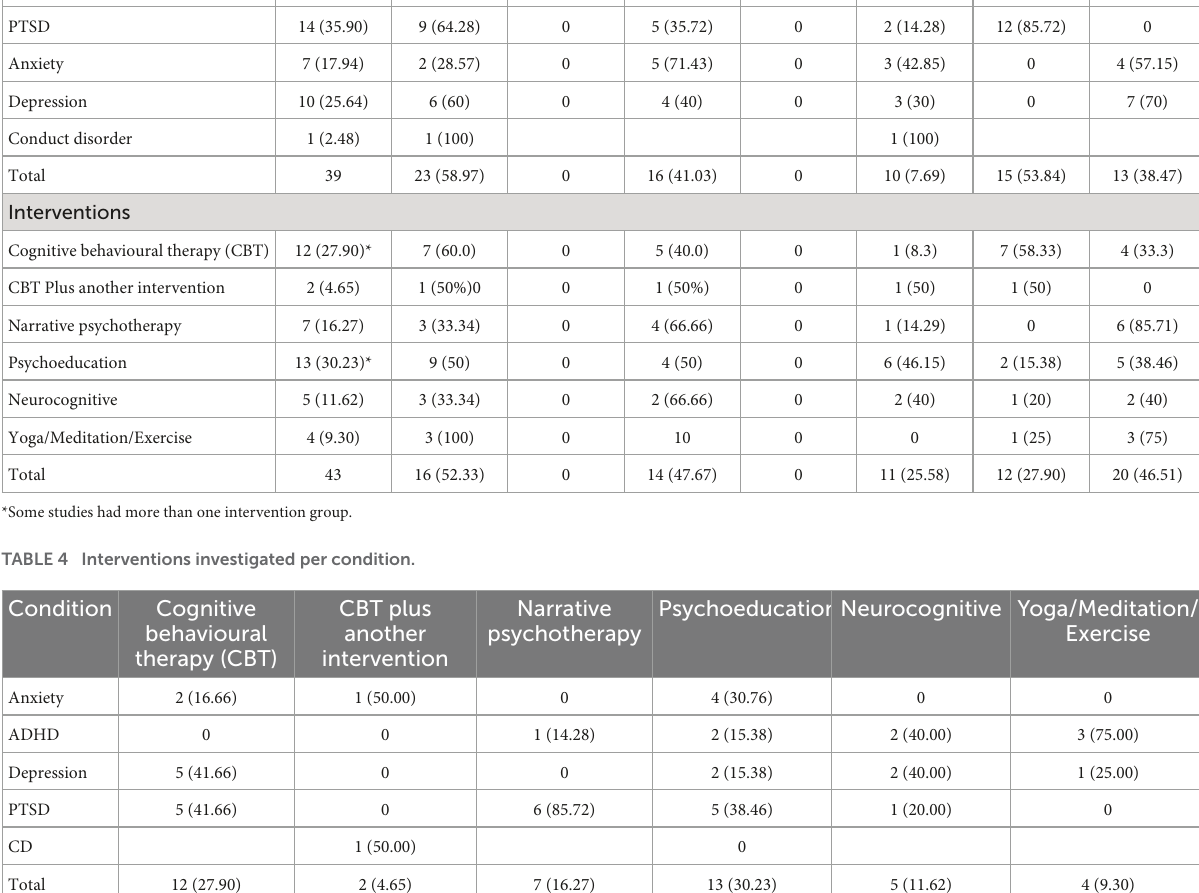
High ROB concerns